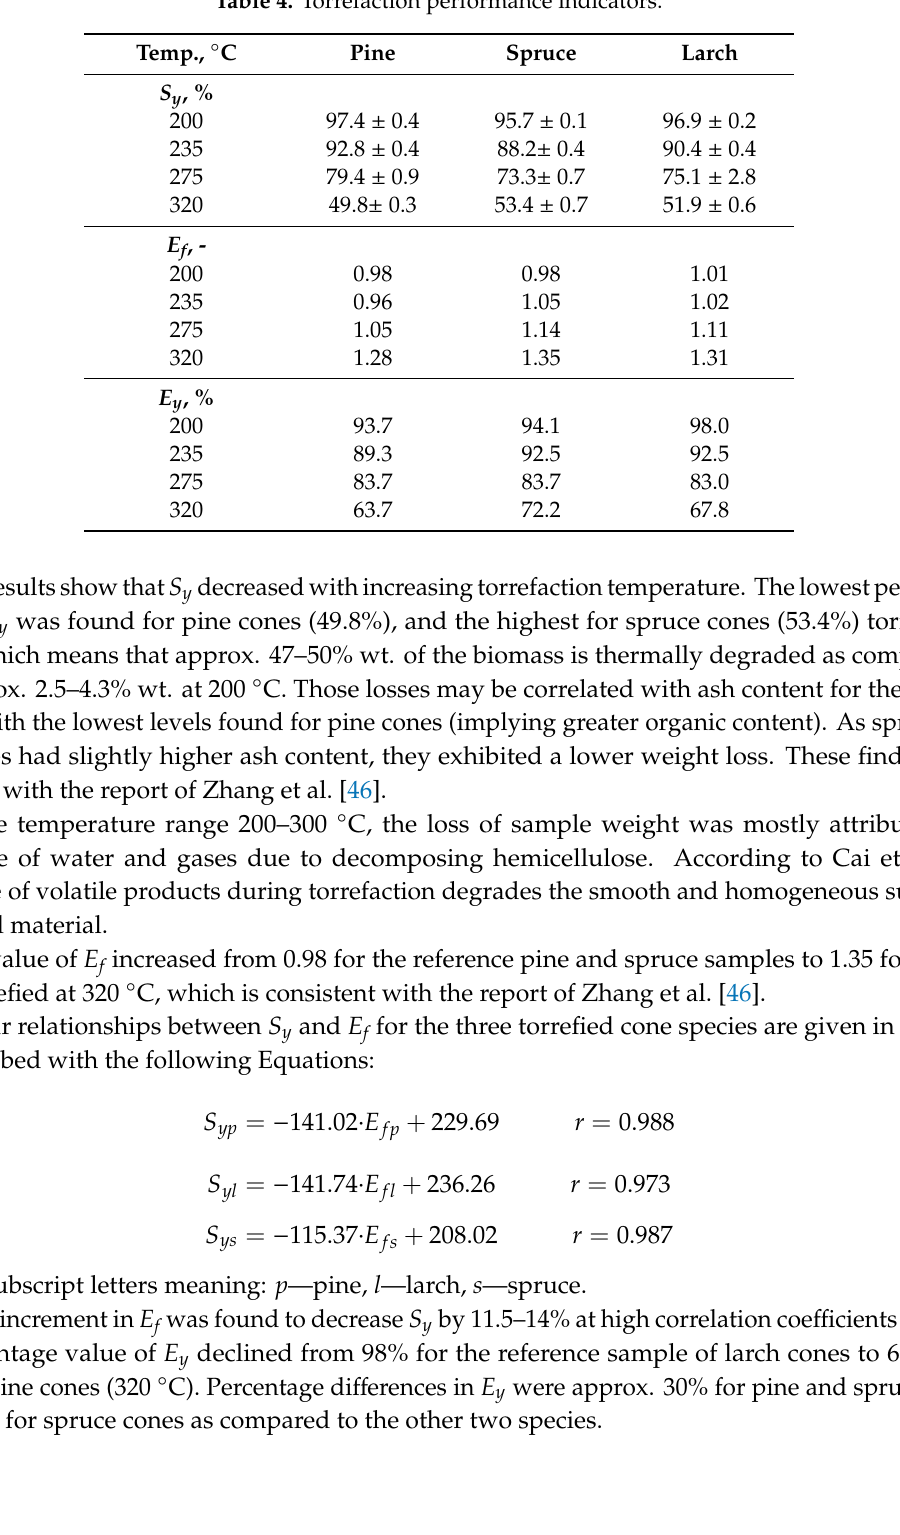
Table 4. Torrefaction performance